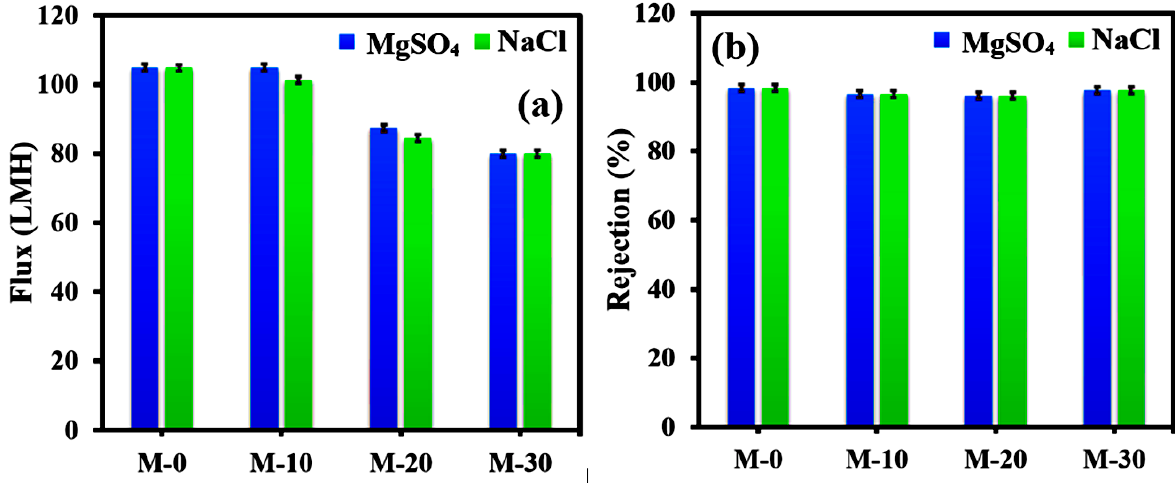
Figure 9. ( a ) Permeate flux and ( b ) salt rejection of all membranes at 20 bar, 25 °C, and 1 g/L salt.